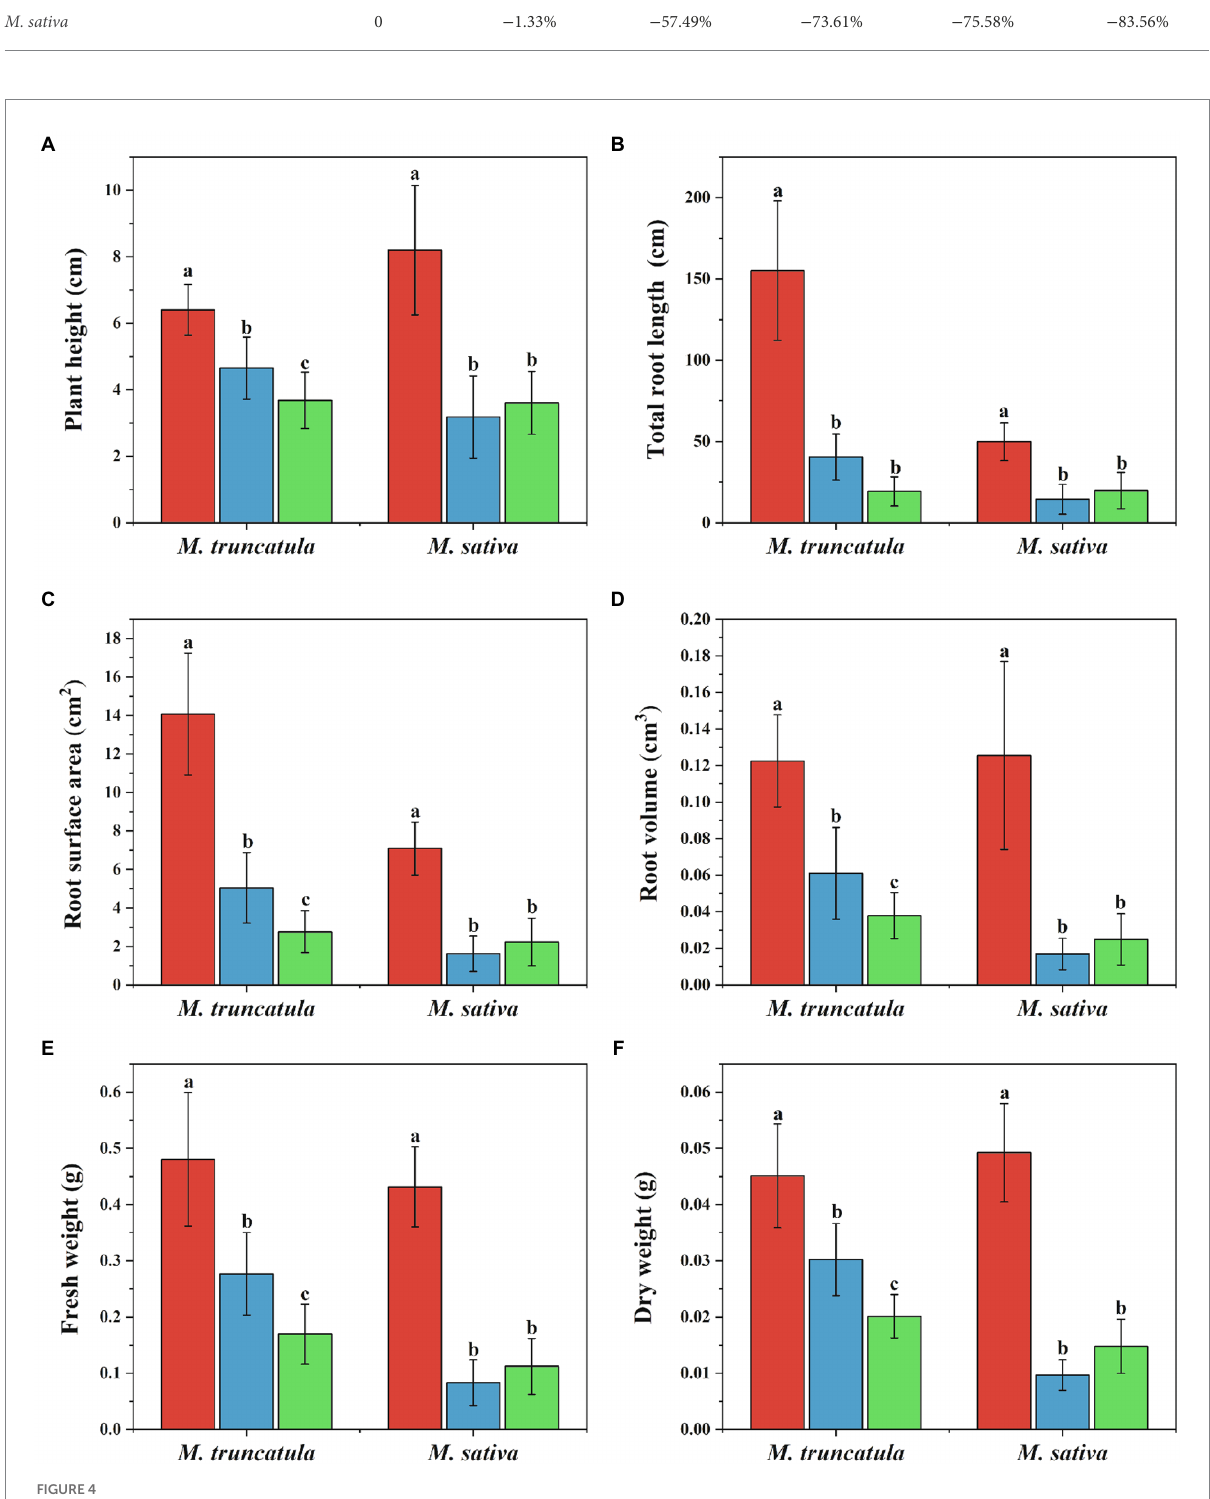
FIGURE 4 Effects of different plant extracts on plant phenotype during the growth of seedlings. (A) Plant height; (B) total root length; (C) root surface area; (D) root volume; (E) fresh weight; (F) dry weight. Values represent means±SD of seven biological replicates. Different letters above the bars indicate significant difference ( p <